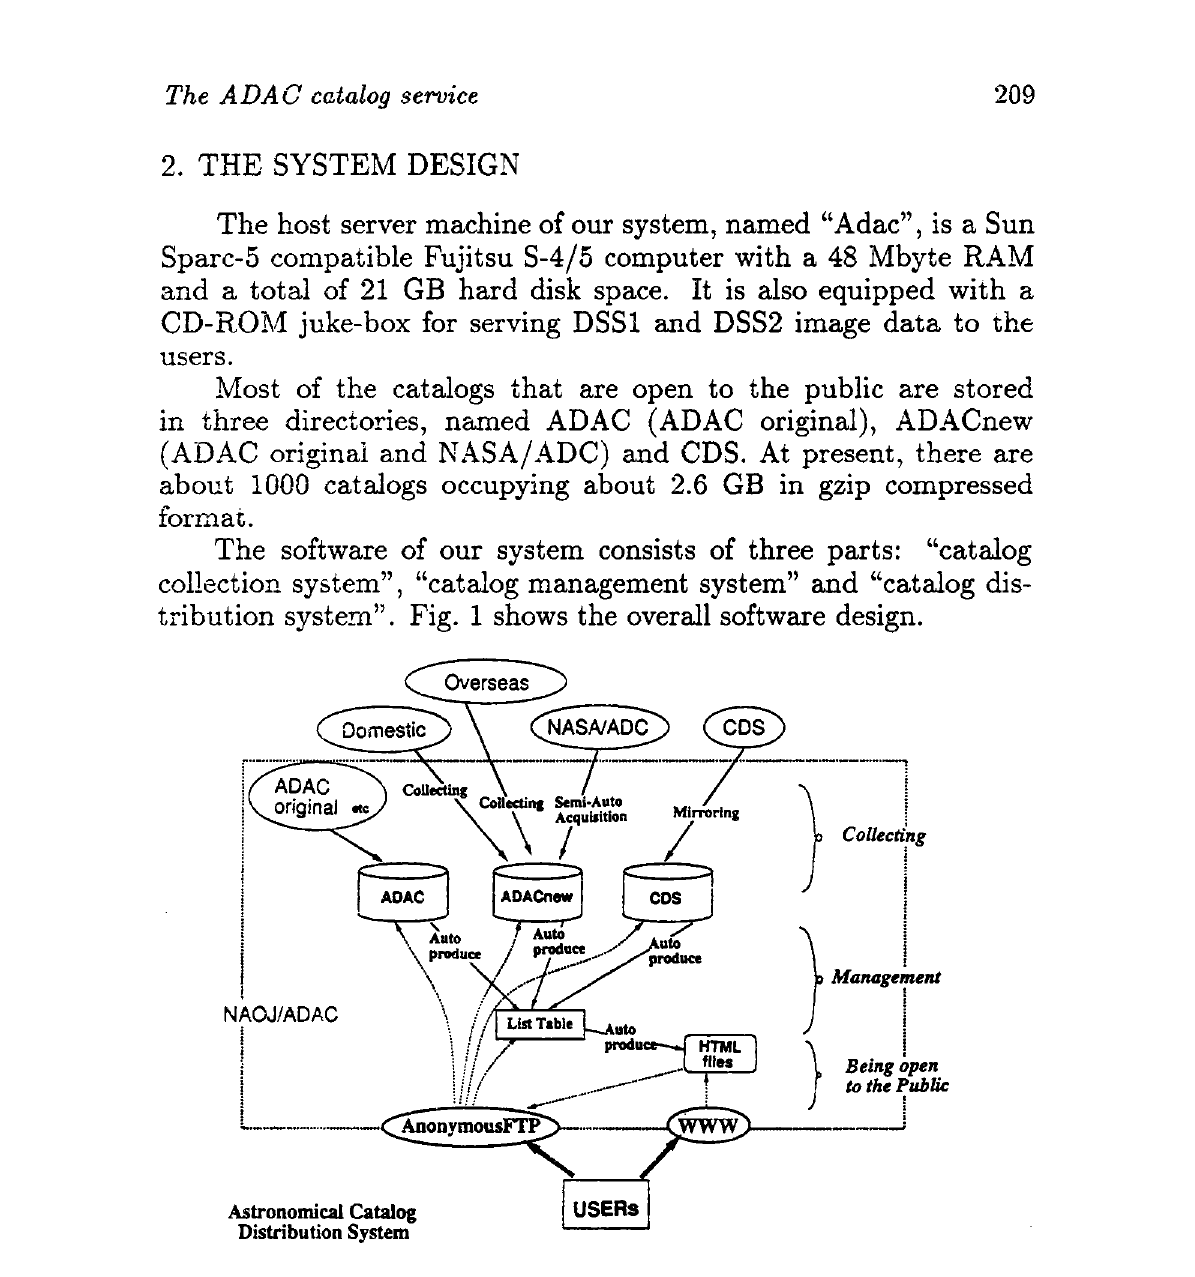
Fig. 1. The overall view of the software design of the Ν AO J/AD AC